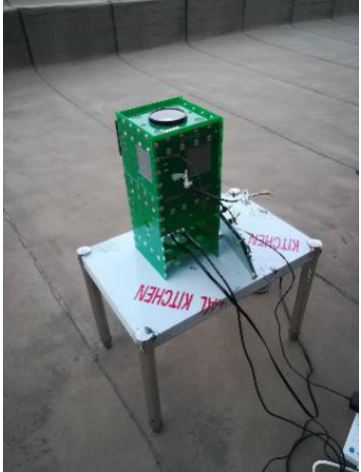
Figure 7. Experiment